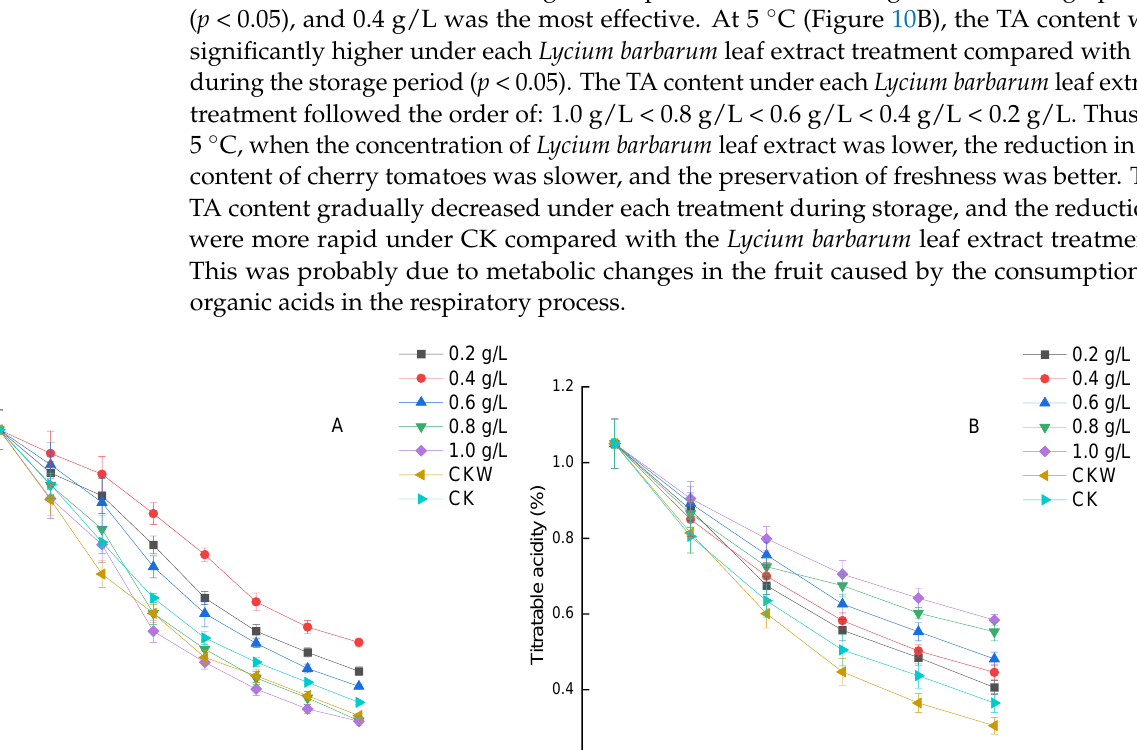
Figure 9. Effects of different Lycium barbarum leaf extract concentrations on the TSS content of cherry tomatoes at 20 °C ( A ) and 5 °C ( B ).